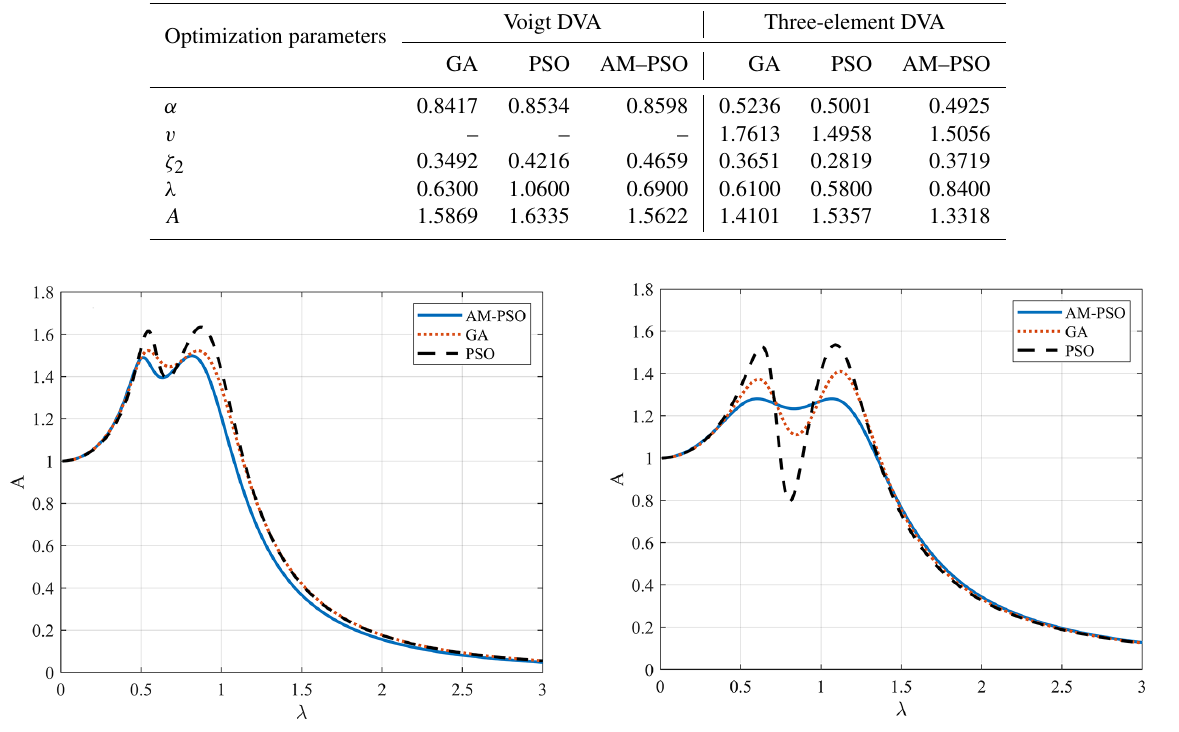
Table 2. Comparison of optimization parameters of DVAs.